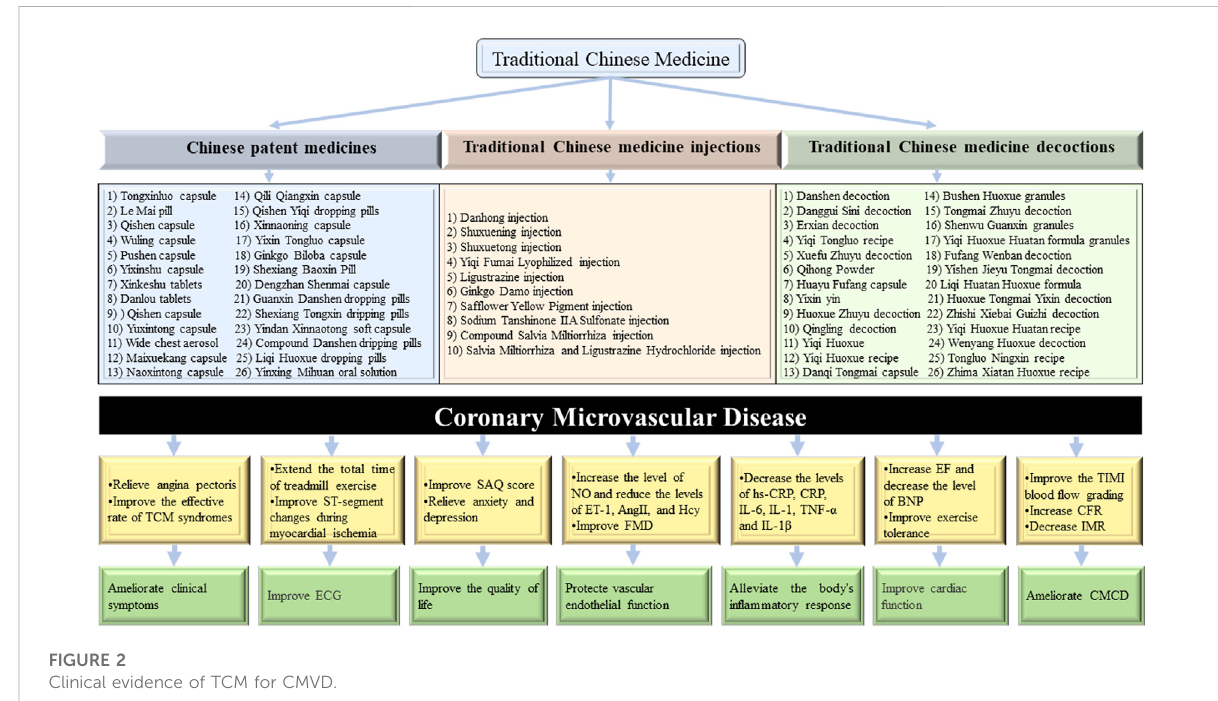
FIGURE 2 Clinical evidence of TCM for